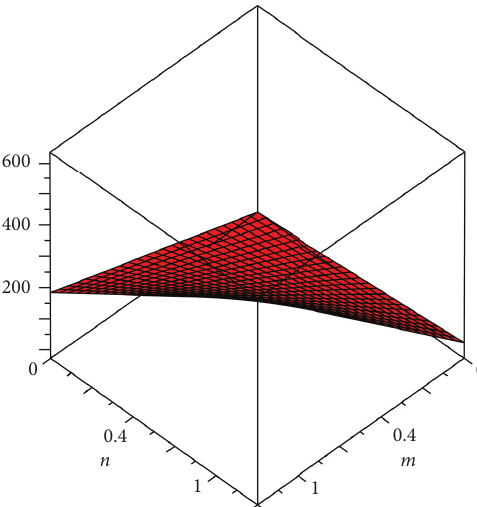
Figure 28: Plots of the first Gourava index for Bil . 3